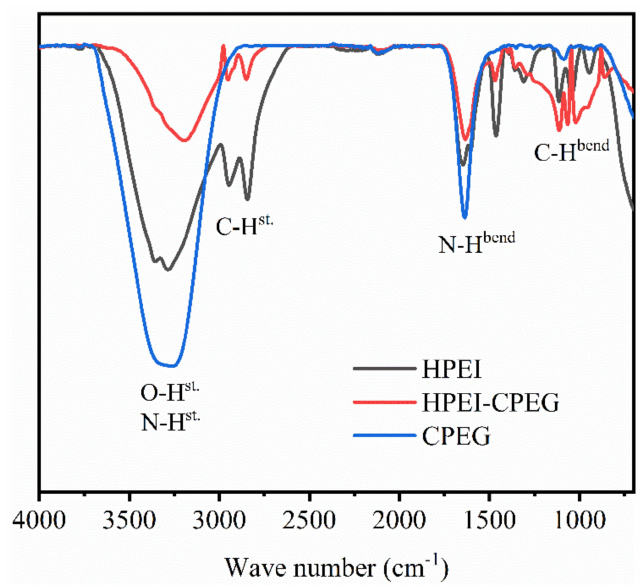
Figure 1. ATR spectra of CPEG, HPEI, and HPEI-CPRG.